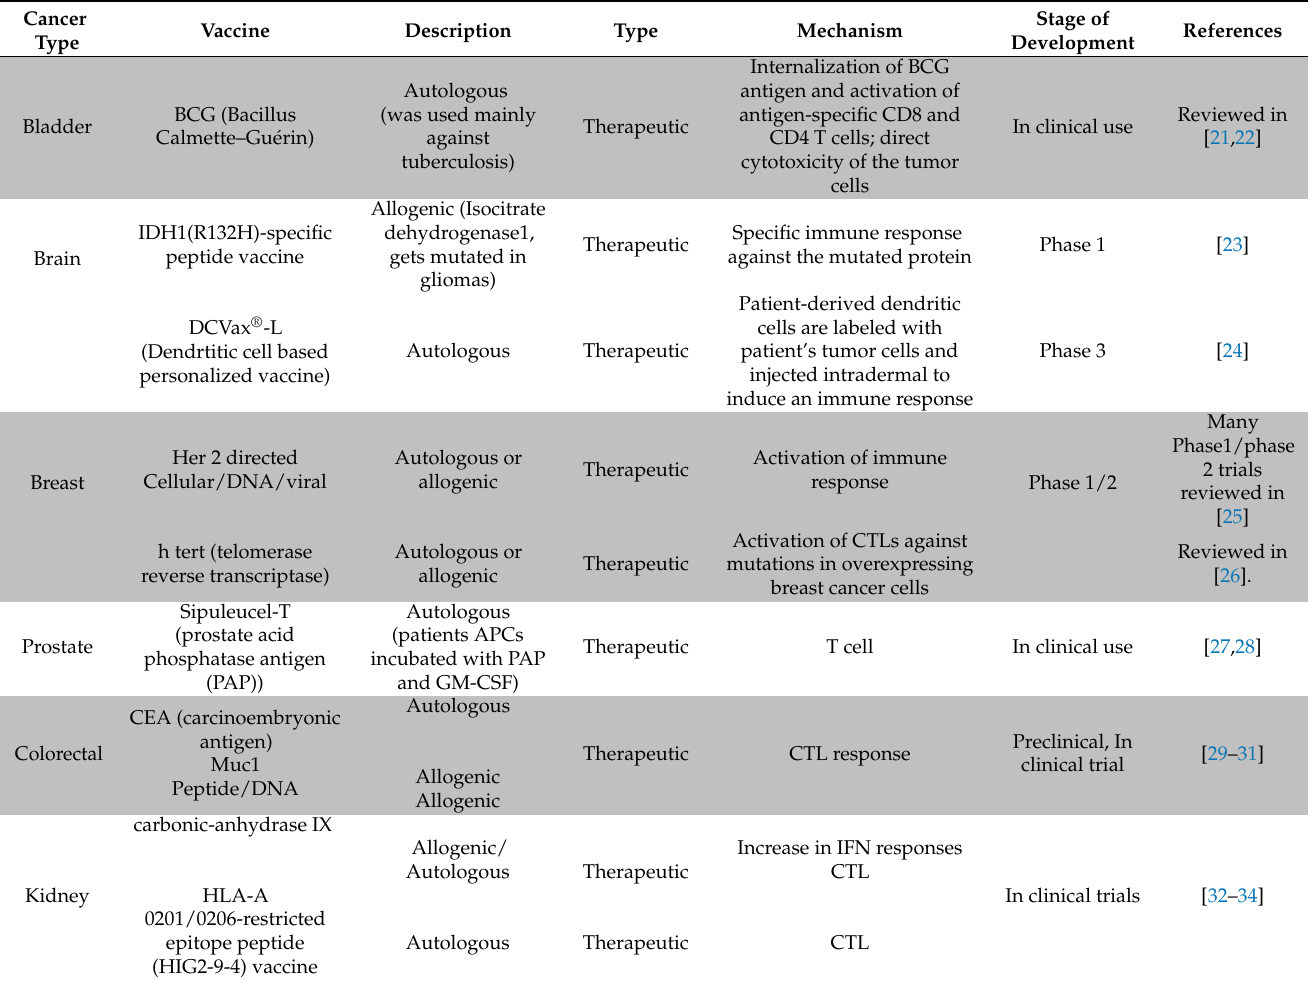
Table 1. Cancer vaccines and their clinical implementation. Summary of a selection of prophylactic and therapeutic vaccines in clinical trials or already in clinical